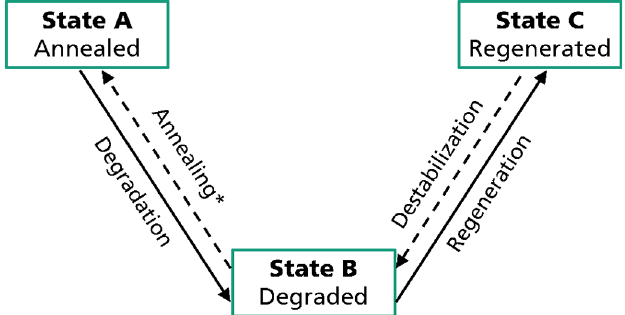
Fig. 1. Three-state model for the BO defect adapted from [16]. *When discussing similar state transitions of the LETID defect, we are using the term “ Temporary Recovery ” for transitions from B